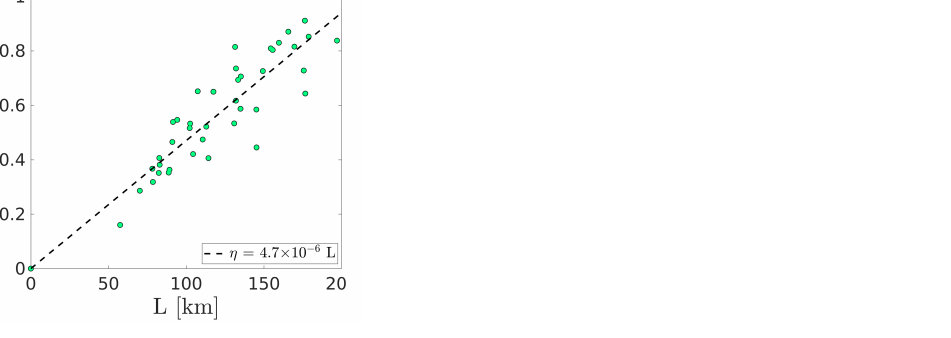
Figure 10. Parameters of the least-square fit to the so-called universal stream function (Equation (3)) for each detected Loop Current ring. The x-axis is the radial length scale and the y-axis is the maximum ADT anomaly η m .